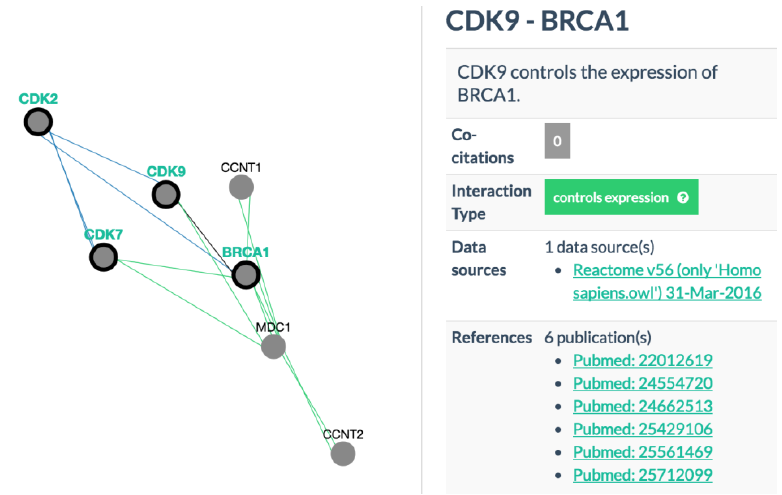
Figure 3. Protein-protein interactions. Screenshots taken from PCViz (Pathway Commons Network Visualizer) for interactions CDK2-BRCA1, CDK7-BRCA1, and CDK9-BRCA1 in which CDK2 controls the state of BRCA1 and CDK7/9 control the expression of BRCA1. We assume that interfering with the function of CDK2/7/9 may affect BRCA1 as well. CDK: cyclin-dependent kinase; BRCA1: breast cancer 1.